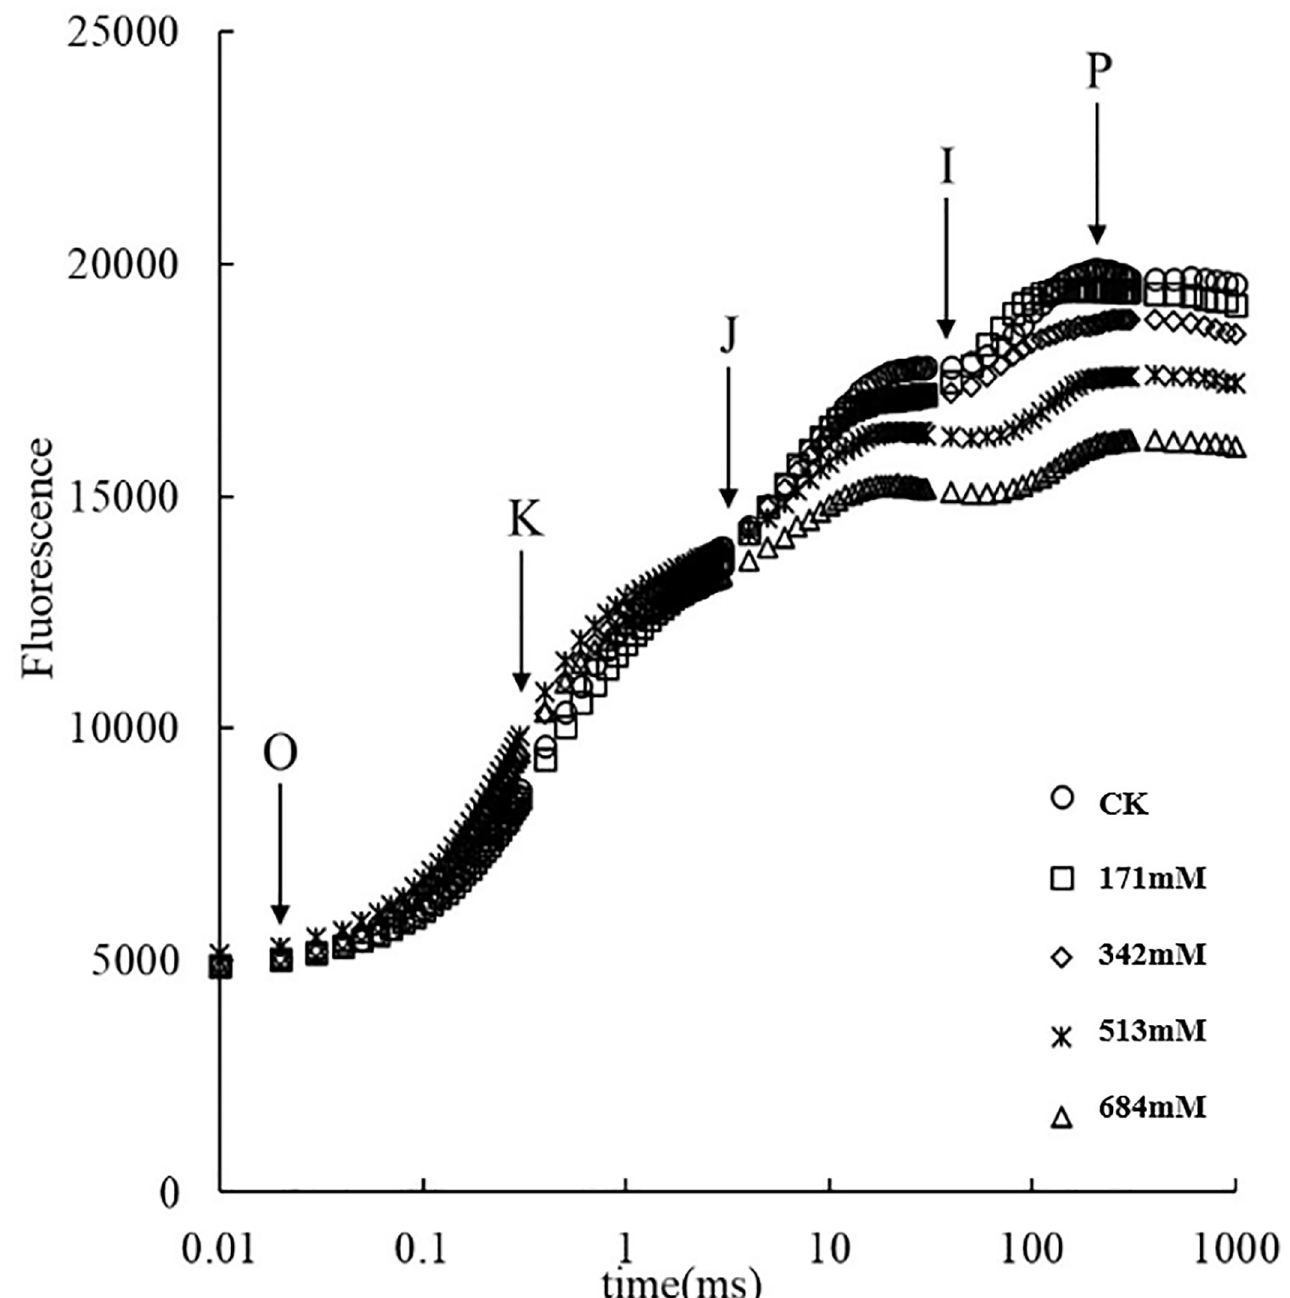
Fig 10. Effect of salt stress on the fast induction curves of chlorophyll a fluorescence (O-J-I-P curve) of Salix alba L. leave. https://doi.org/10.1371/journal.pone.0260086.g010 were significantly lower than those of the control. When the NaCl concentration was 342mM, the C o and φ Eo were significantly lower than the 11.1% and 11.9% of the control group, respectively. Compared with the control group, salt stress increased the quantum ratio ( φ Do) of Salix alba leaves for heat dissipation. When the NaCl concentration was 513mM, φ Do was significantly higher than that of the control.